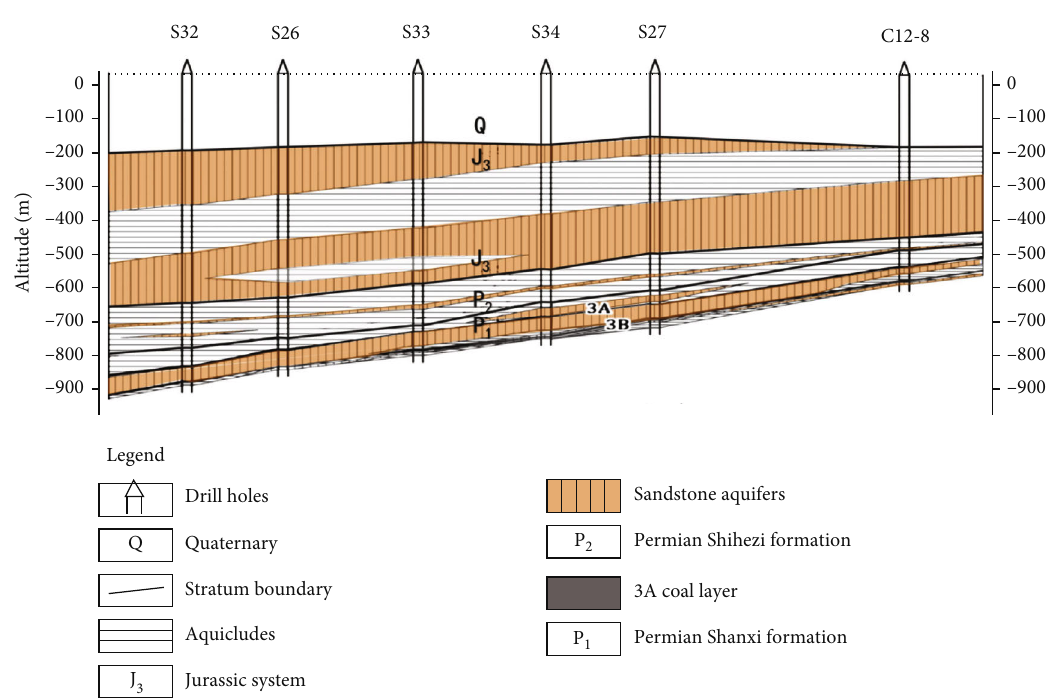
Figure 1: A general overview of the fl ow of this study.